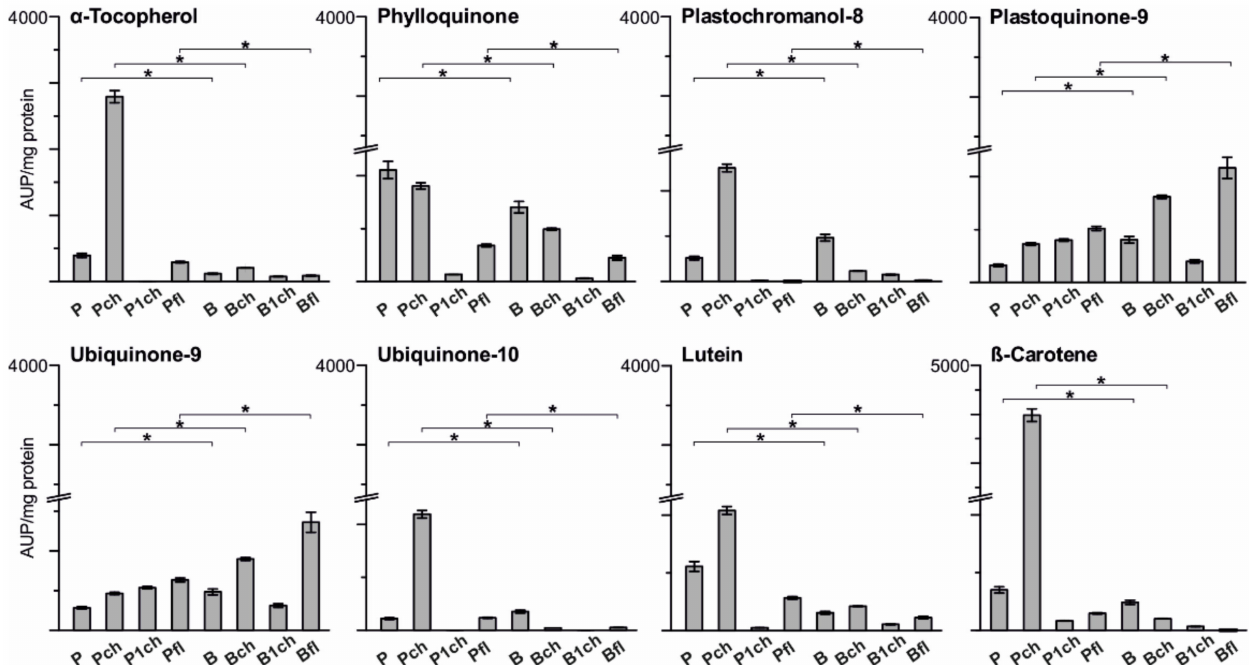
Figure 6. Composition of prenyl lipids and carotenoids isolated from bean (B) and pea (P) plastoglobules (PGs) in control conditions; first leaf (fl) and mature plants, and after the first (1ch) and seventh (ch) day of chilling stress treatment. The composition was presented in mg of total PG protein in precipitated fraction. Pairs of results marked with an asterisk (*) differ significantly at p = 0.05 (one-way ANOVA with posthoc Tukey